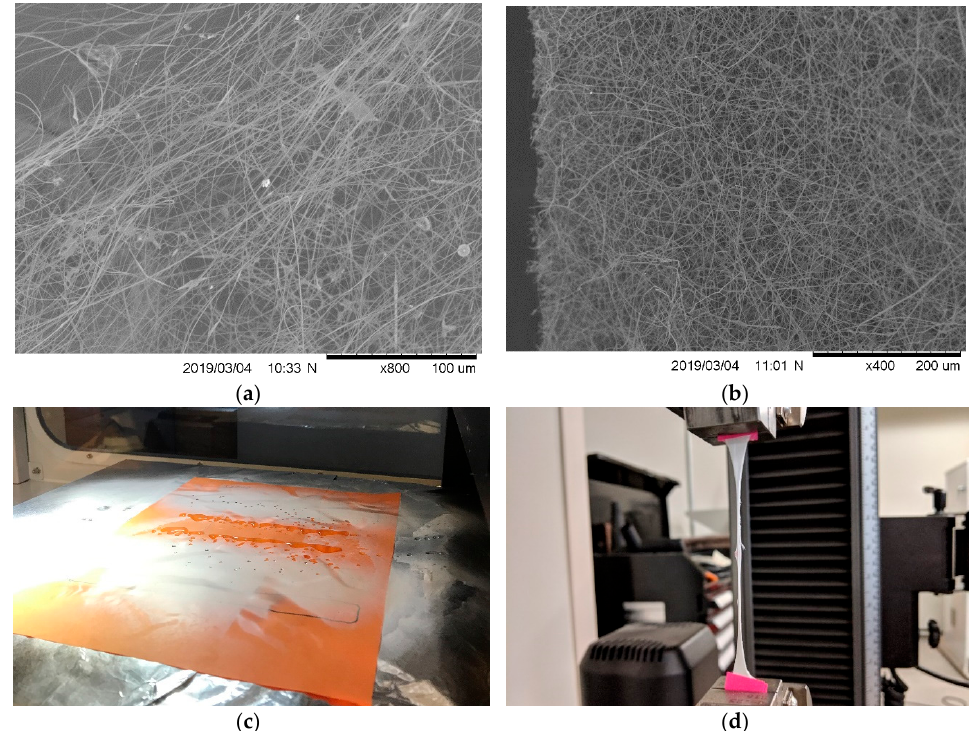
Figure 1. ( a ) 50 PVA 50 CNC drawn specimen taken by SEM after tensile testing, ( b ) the 50 PVA 50 CNC mat